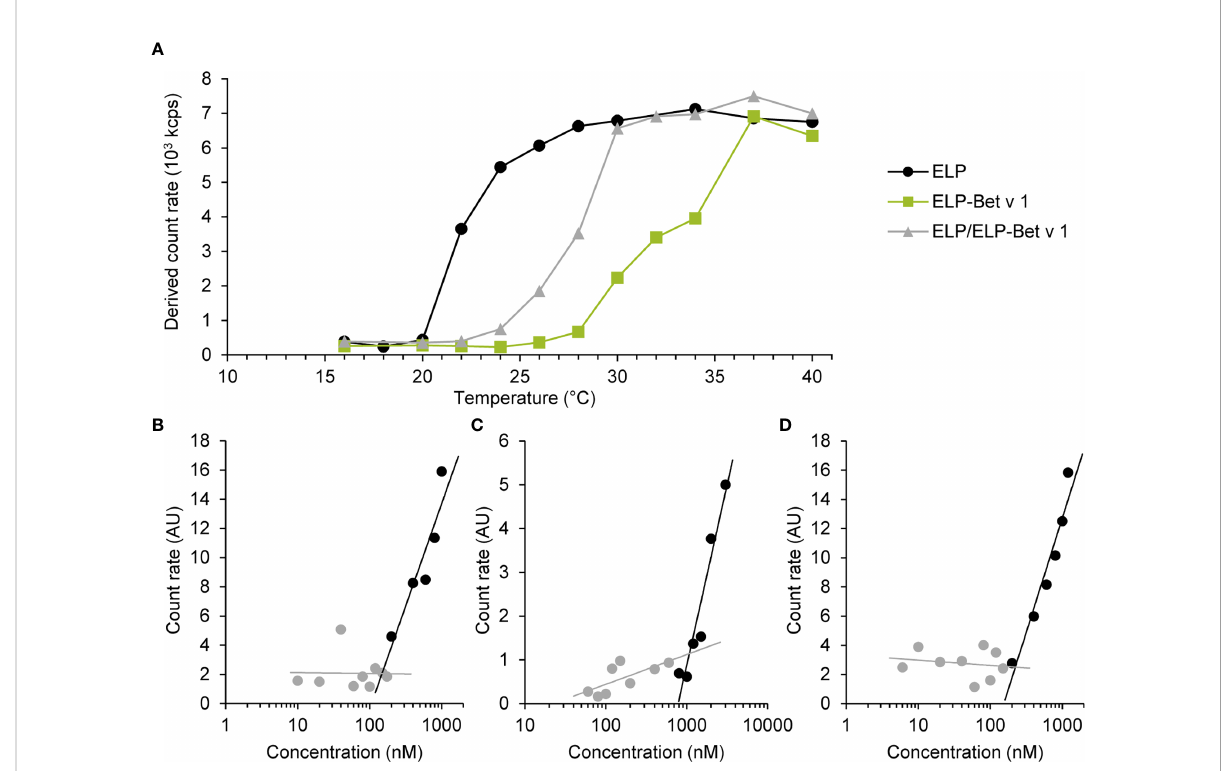
FIGURE 2 Critical micelle temperature (A) and concentration (B – D) of ELP, ELP-Bet v 1 and ELP/ELP-Bet v 1. (A) Polypeptide solutions of 10 µM in 10 mM PB were measured by SLS at varying temperatures. The CMT is determined as the temperature value above which the count rate exceeds the baseline measurement: ~22°C (ELP), 24°C (ELP/ELP-Bet v 1) and ~28°C (ELP-Bet v 1). (B – D) Various concentrations of ELP (B) , ELP-Bet v 1 (C) and ELP/ELP-Bet v 1 in 10 mM PB were measured with SLS at 37°C by using a fi xed attenuator of 11. Count rates were normalized to the count rate of the buffer. Gray data represent samples that did not contain particles according to the autocorrelation functions (Figure S5); black data represent the samples for which the autocorrelation functions had a sigmoidal shape. CMCs at 37°C were determined by calculating the concentration at the intercept of both trend lines: 0.15 µM (ELP), 1.1 µM (ELP-Bet v 1) and 0.22 µM (ELP/ELP-Bet v